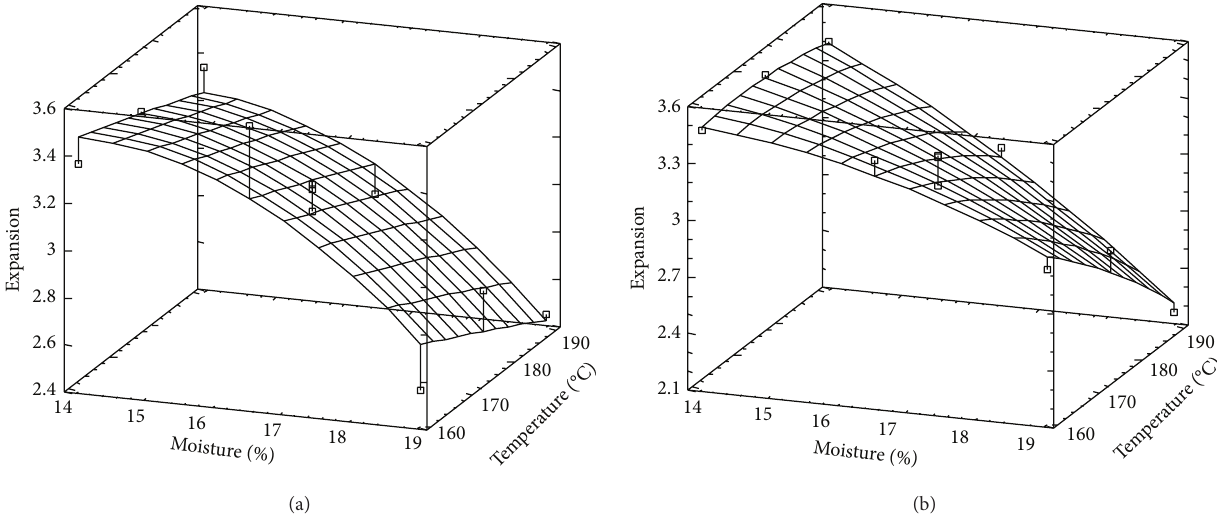
Figure 2: Surface response for expansion corresponding to Fortuna rice variety (a) and Paso 144 rice variety